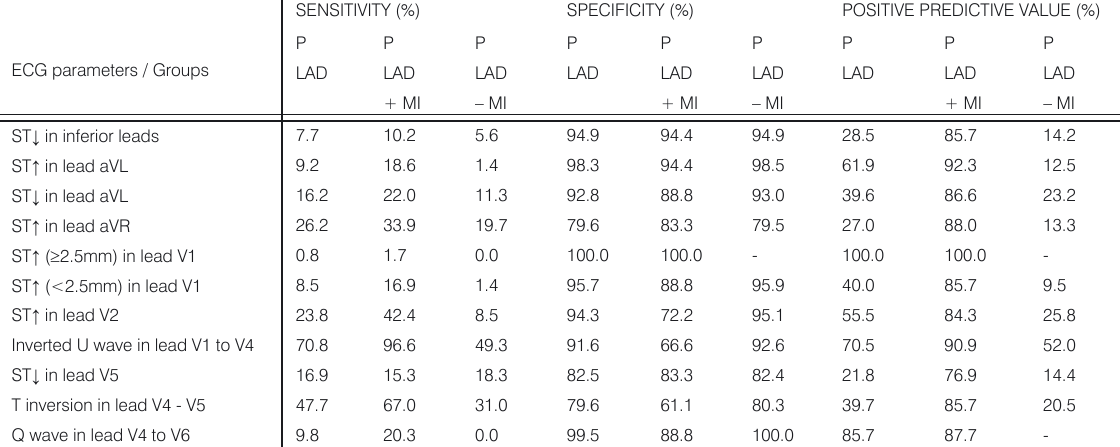
Table 3. Sensitivity, specificity and positive predictive value of each ECG parameters in different